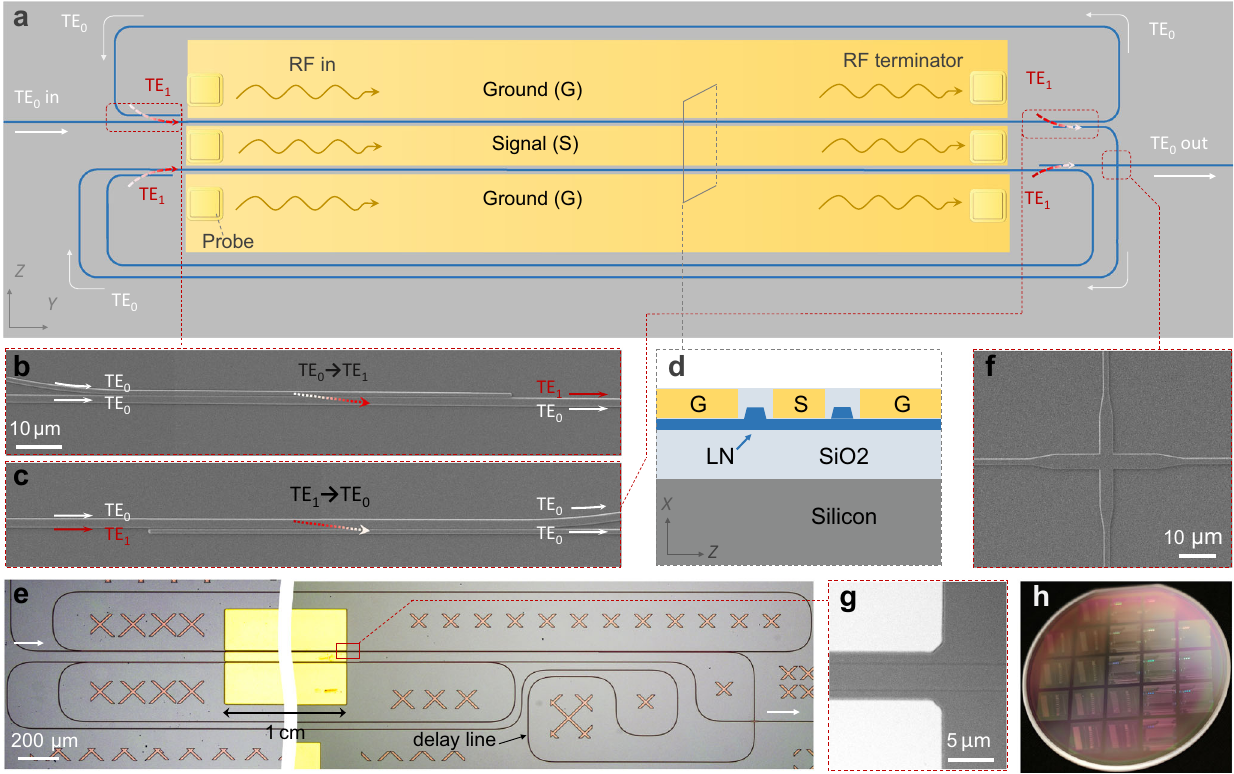
Fig. 1 Schematic of the power-ef fi cient on-chip electro-optic (EO) comb generator. a Device layout, where light travels through the phase modulation region (yellow area) for a total of 4 round trips via multiple TE 0 /TE 1 mode conversions (TE 0 : fundamental transverse-electric mode, TE 1 : second-order transverse-electric mode). b , c Scanning electron microscope (SEM) images of the adiabatic mode multiplexers. d Cross-sectional schematic of the modulation area. e Microscope image of the full EO comb generator, consisting of a 1-cm-long modulation region and engineered waveguide delay lines. f , g SEM images of the low-loss waveguide crossing ( f ) and the EO modulation area ( g ). h Camera image of a fabricated 4-inch lithium niobate (LN) on insulator